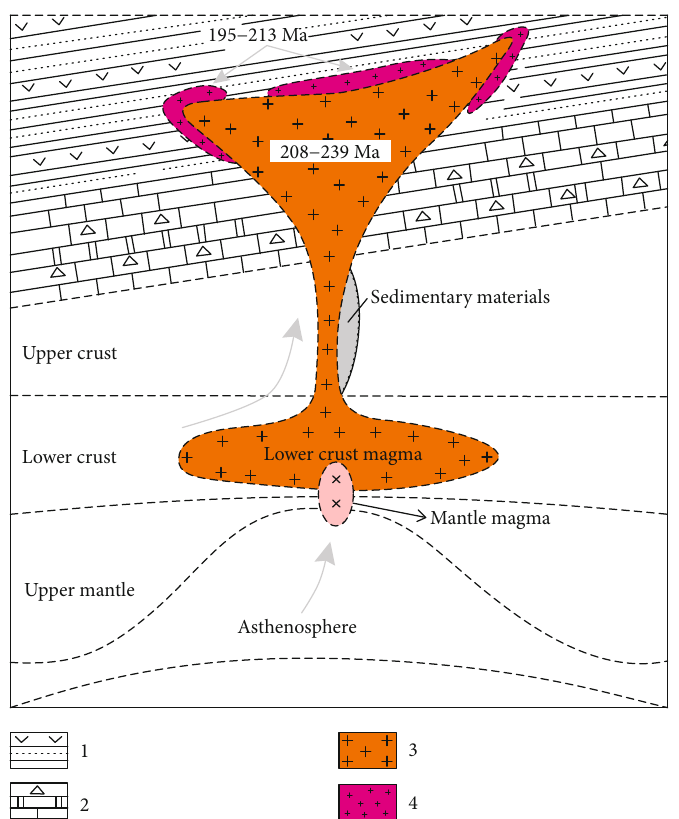
Figure 23: The diagenetic model of the granite porphyry and granodiorite plutons in the Yangla copper deposit, Yunnan, China. 1 — sand- slate formation, 2 — carbonate formation, 3 — granodiorite plutons, and 4 — granite